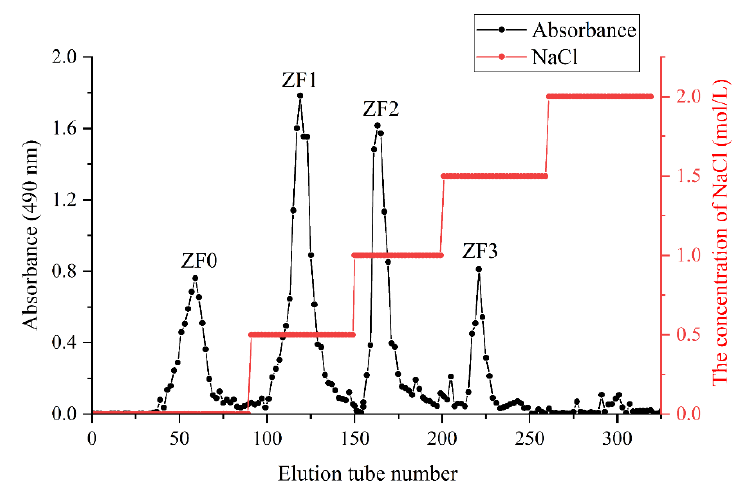
Figure 2. Stepwise elution curve of ZF on the DEAE cellulose 52 ion column chromatography column. Red indicates the concentration of NaCl. The fucoidans obtained from 0, 0.5, 1, and 1.5 mol/L NaCl eluents were called ZF0, ZF1, ZF2, and ZF3, respectively.